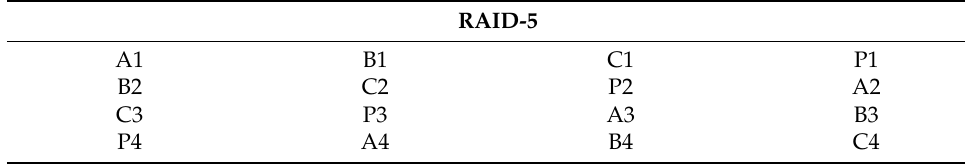
Table 2. RAID-5 configuration structure.